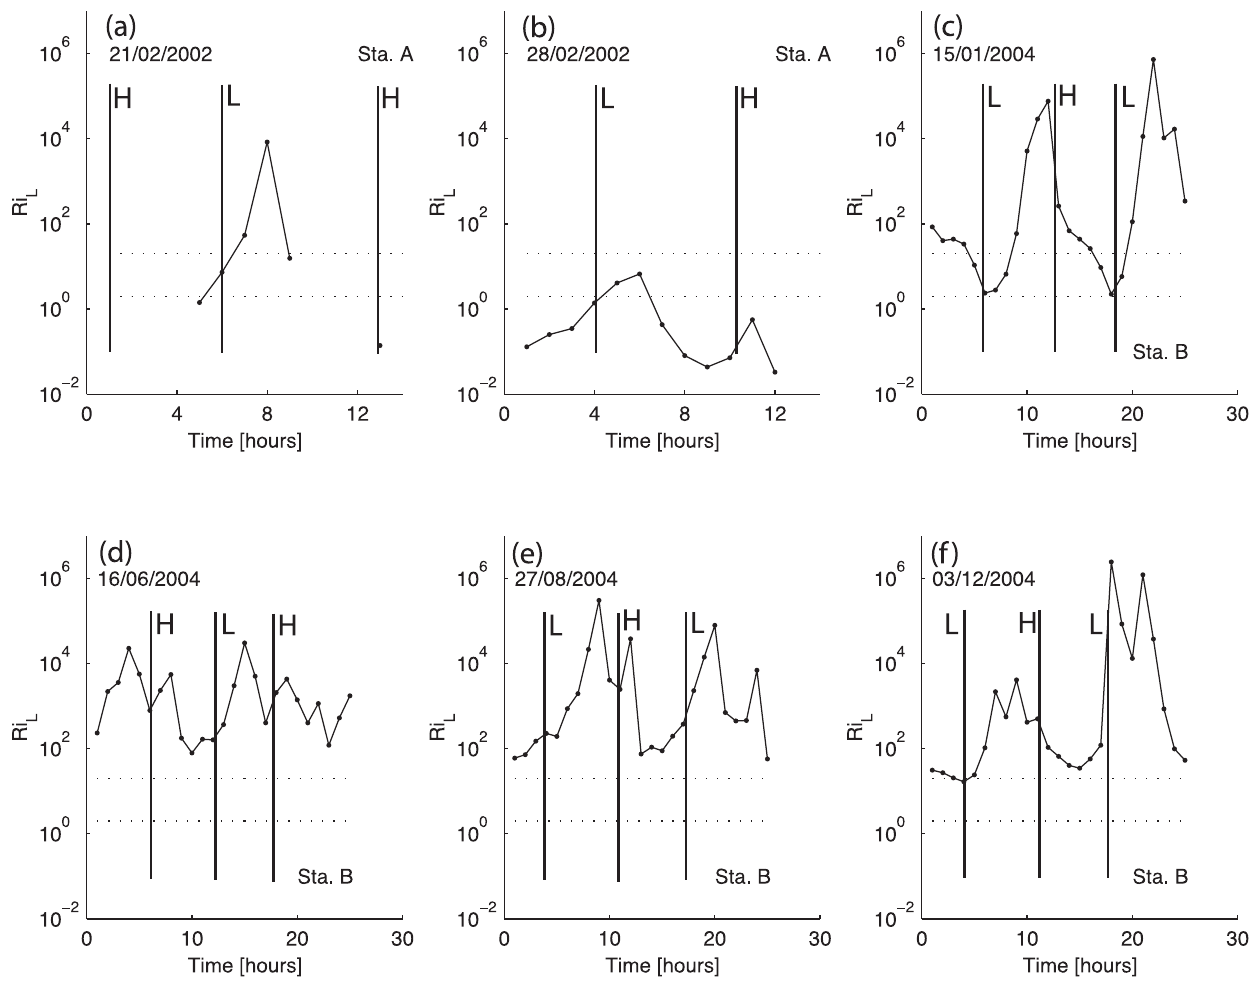
Figure 6. Temporal variation of the layer Richardson number. The dotted lines ( Ri L equal to 2 and 20) are the limits of weak vertical stability.